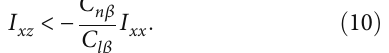
Figure 5: Dutch-roll mode changes at multiples of I E: Ma = 1 : 4